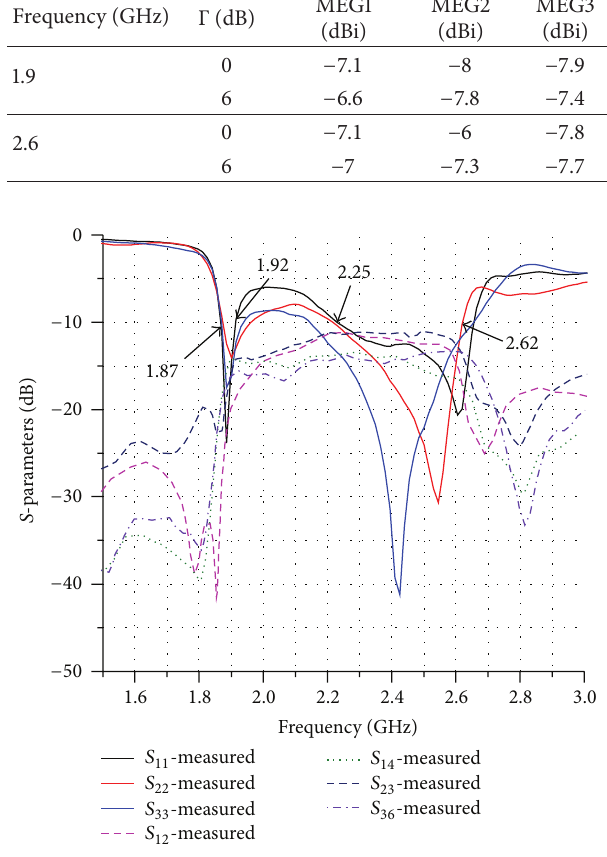
Figure 16: The 𝑆 -parameters of antennas 1, 2, and 3.